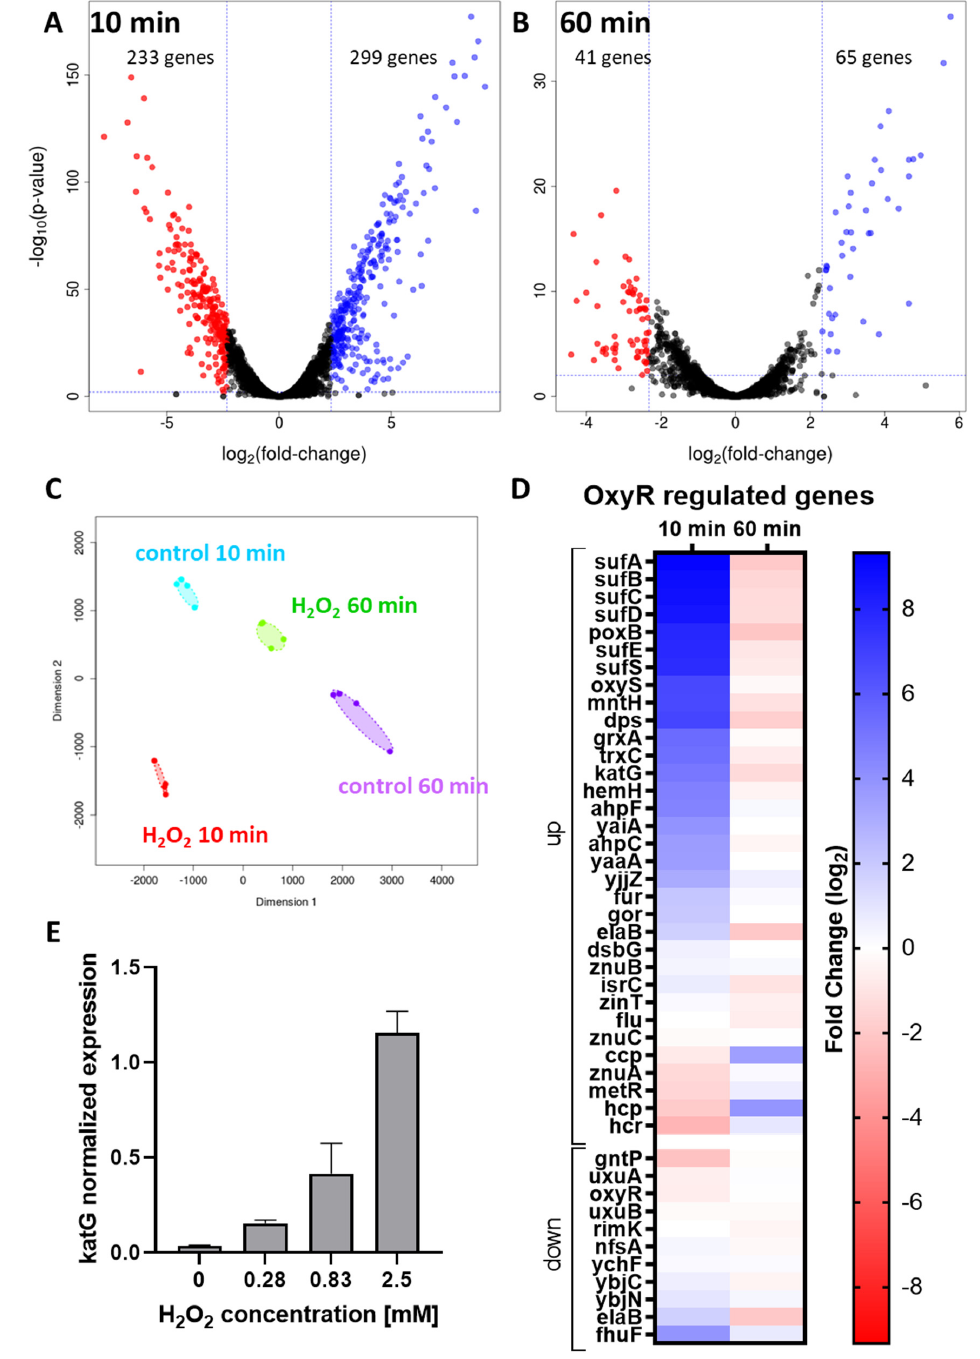
Figure 2. Gene expression at 10 and 60 min after exposure of E. coli BW25113 to 2.5 mM H 2 O 2 . Volcano plots representing the dysregulated genes at 10 ( A ) and 60 min ( B ) after H 2 O 2 addition compared to respective untreated cells. Blue dots represent significantly up-regulated genes and red dots represent significantly down-regulated genes; thresholds were set as p -value = 0.01 and fold-change ≥ 5; ( C ) Multi-Dimensional Scaling plot of all samples, each color represent a condition, each dot a sample. Distances between dots represent the coefficient of variation of expression between samples for the top 500 dysregulated genes that best distinguish the samples; ( D ) Heatmap of the expression of genes of the OxyR regulon with up-regulated genes in blue and down-regulated genes in red [28] (fold change); ( E ) Catalase katG mRNA expression levels in response to increasing H 2 O 2 concentrations, as measured by qRT-PCR (mean +/ − SEM, N =